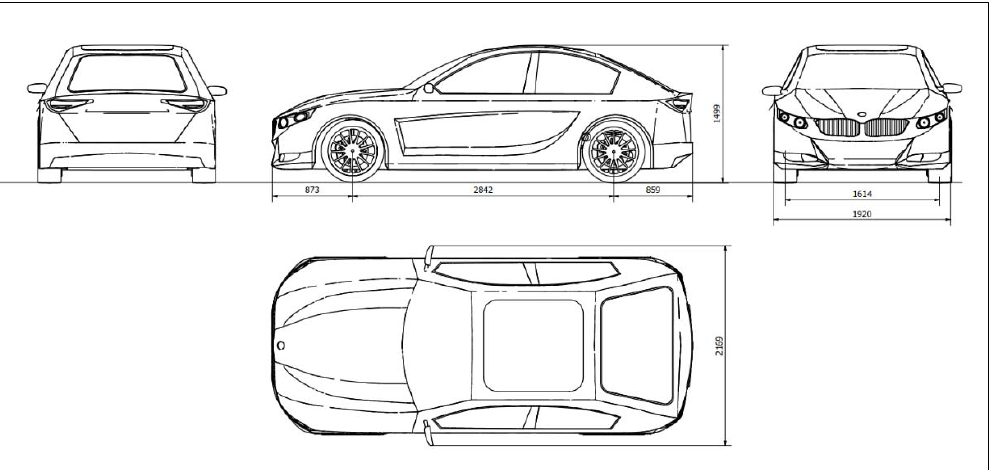
Figure 11. Orthogonal projections of Blitz Vision AS.